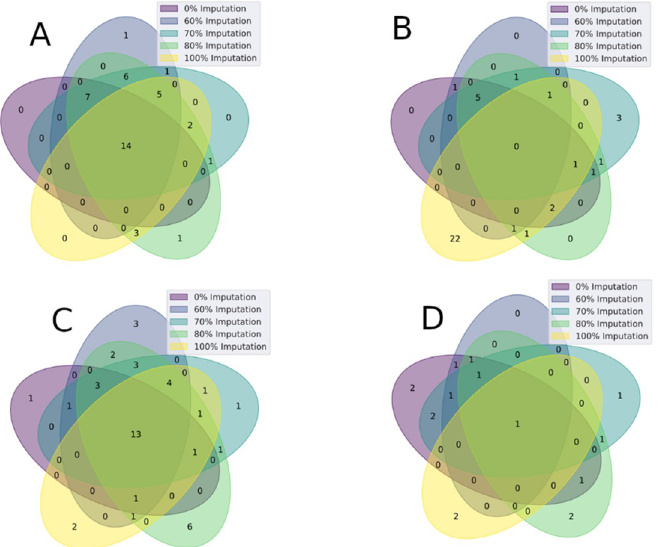
Fig 3. Venn overlaps of the metabolites identified by knockoff filtering of the C18 Negative (A), HILIC Positive (B), HILIC Negative (C) and the C8 Positive (D) chromatography groups.